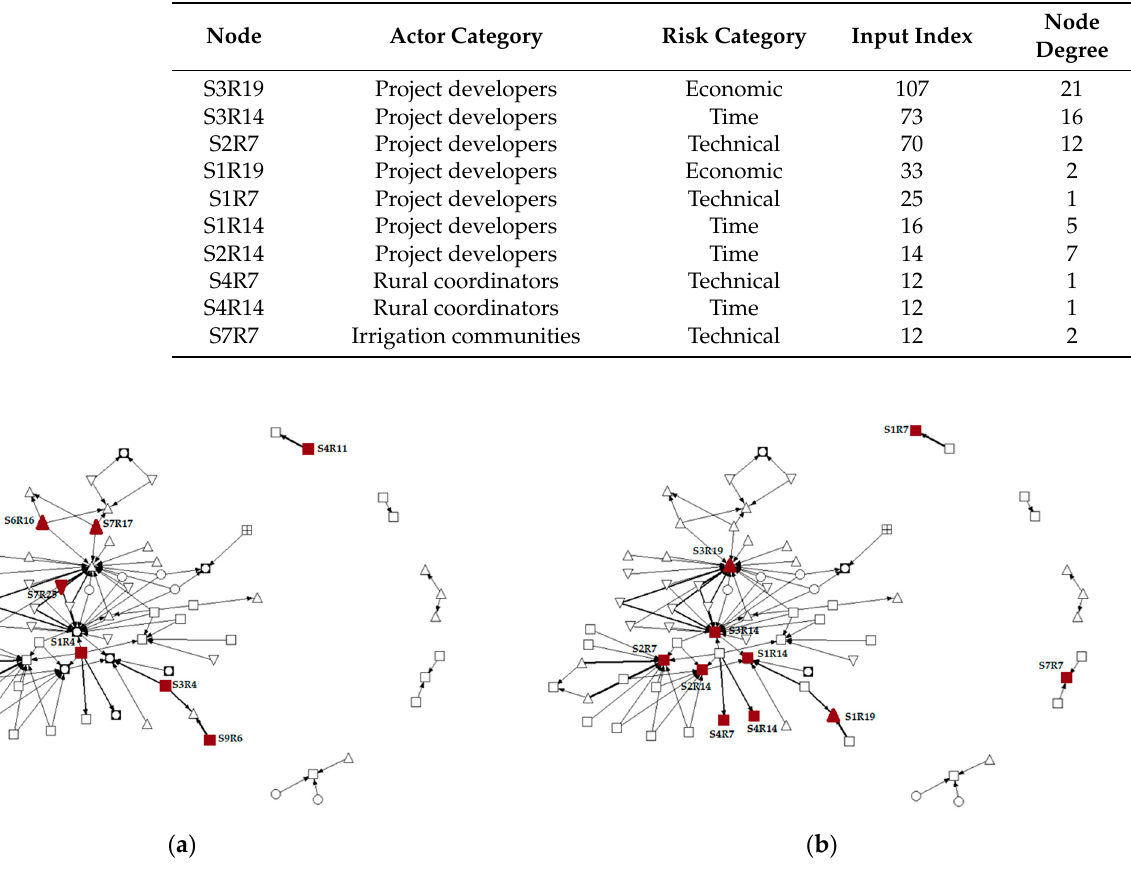
Figure 7. ( a ) Graphic representation of the primary nodes by output centrality; ( b ) graphic representation of the primary nodes by input centrality.